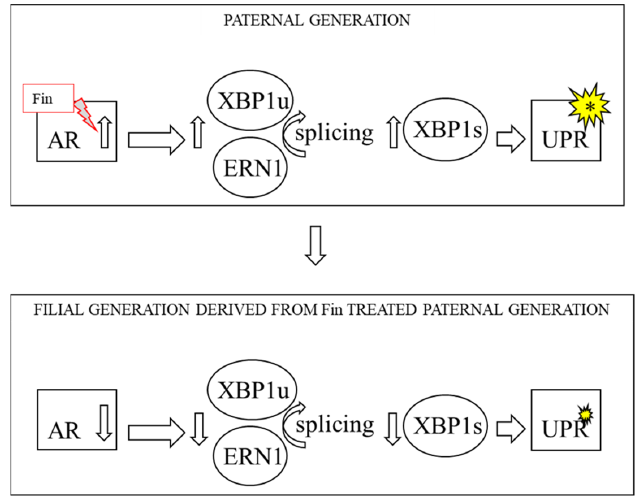
Figure 1. Androgen receptors can modulate the splicing of XBP1s via the ERN1 pathway, which in response activates UPR signaling. We propose that Fin treatment in the paternal generation can also change the AR receptor balance in mature filial generation. ( Upper panel ) Effects of Fin in the paternal generation. ( Lower panel ) Effects of treatment of the paternal generation with Fin in mature filial generation. AR—androgen receptor; Fin—finasteride; XBP1s—X ‐ box binding protein 1 (spliced), XBP1u—X ‐ box binding protein 1 (unspliced), ERN1—endoplasmic reticulum ‐ to ‐ nucleus signaling 1, UPR—unfolded protein response.